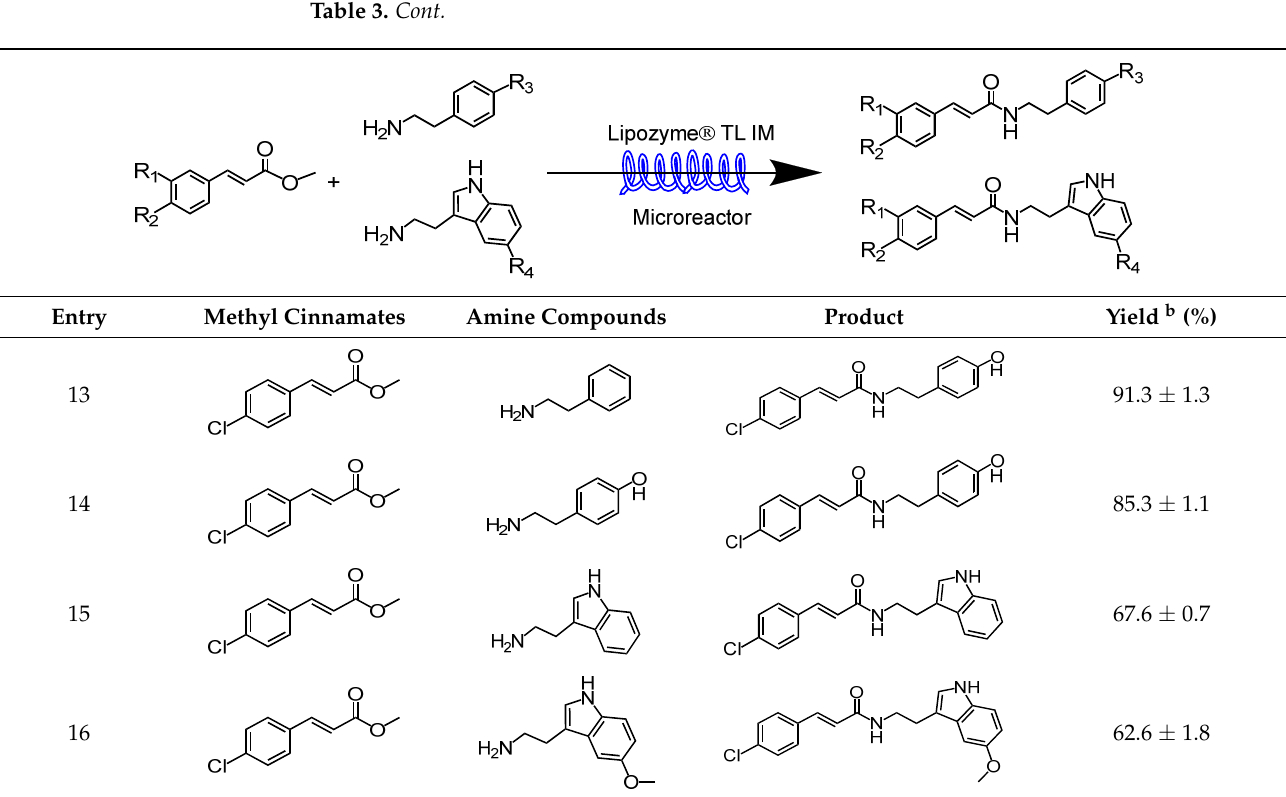
Table 3. Effect of substrate structure on the synthesis of cinnamamide derivatives catalyzed by Table 3. Cont. Lipozyme ® TL IM in continuous-flow microreactors a .